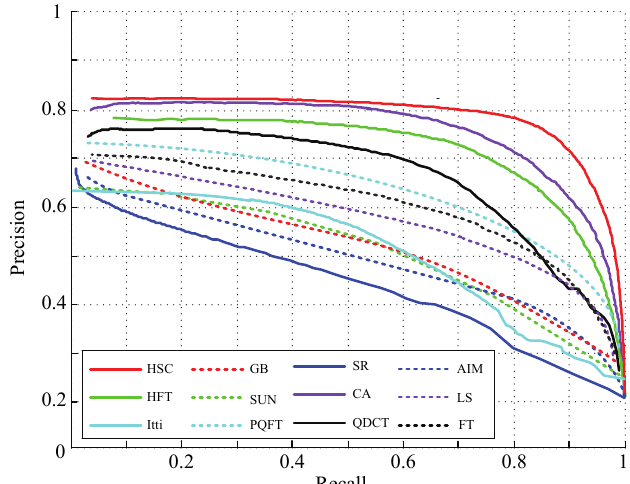
Figure 6. The Precision-recall curve for naive thresholding of saliency maps using